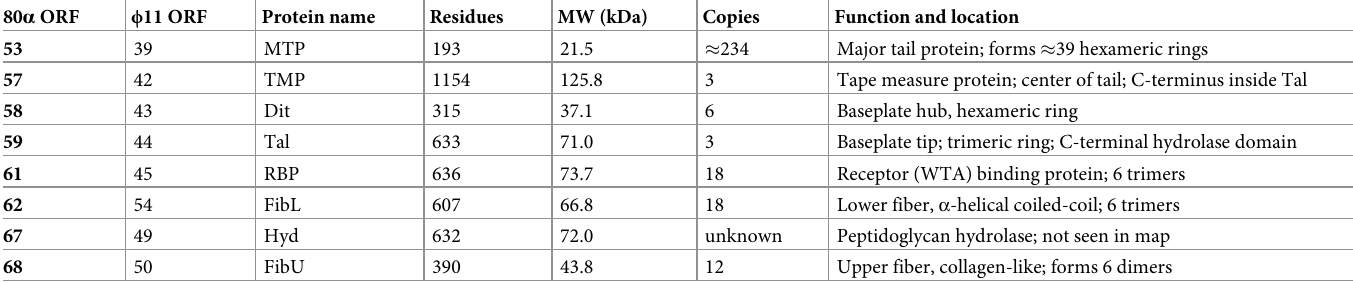
Table 1. List of 80 α tail and baseplate proteins, showing ORF numbers in 80 α and corresponding numbers in ϕ 11, protein name, number of amino acid residues and calculated molecular weight, number of copies per particle, and a description of protein functions and location in the virion. 80 α